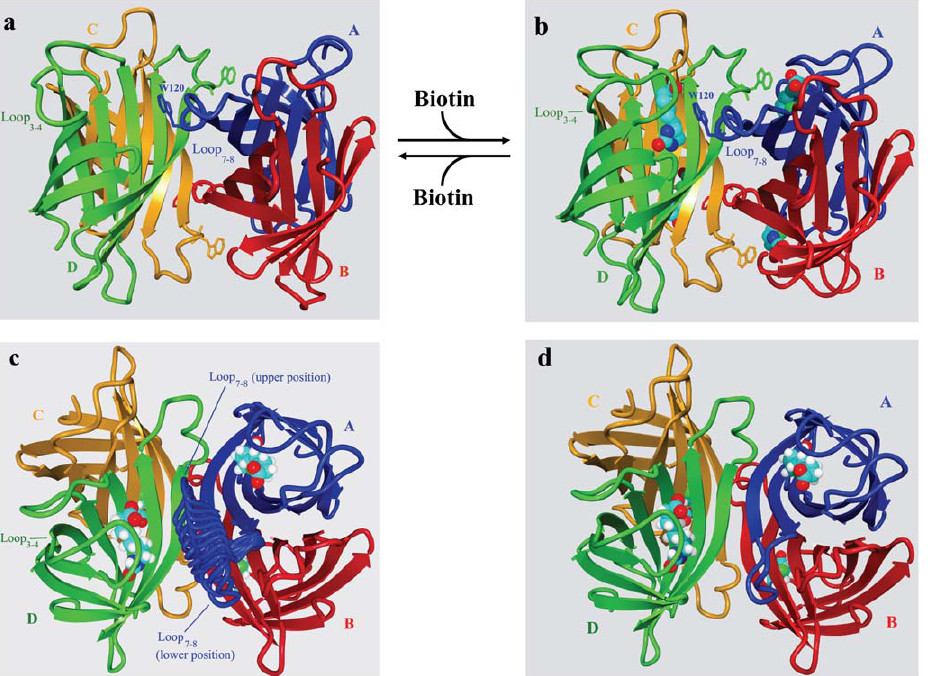
Figure 1. Biotin entry and exit paths in wild-type streptavidin (panels a and b) and models of the engineered mobile loop 7–8 in streptavidin (panels c and d). Subunits A, B, C and D in wild-type streptavidin are colored in blue, red, yellow and green, respectively. Loop 3–4 in subunit D is in the open conformation as shown in panel a to allow biotin binding. Trp-120 (blue) from subunit A (blue) is required to form a complete biotin binding pocket in subunit D (green). With biotin binding, loop 3–4 is in the closed position as shown in panel b. To develop an engineered streptavidin (8-aa-loop-H127C) with reversible biotin binding, loop 7–8 in wild-type streptavidin was replaced by an engineered mobile loop to function as a dynamic gateway for the exit of the bound biotin. The engineered mobile loop 7–8 in subunit A is modeled in 10 different positions to illustrate its dynamic nature (panel c). The blue loop (loop 7–8 ) in the upper positions will form a wall as part of the biotin binding pocket for the subunit D (green). At these stages, this gate is in the closed state. When loop 7–8 is in the lower position (panels c and d), the gate is in the open state. With loop 3–4 in subunit D in the closed conformation, biotin still can possibly escape from the biotin binding pocket at this stage (panel d).